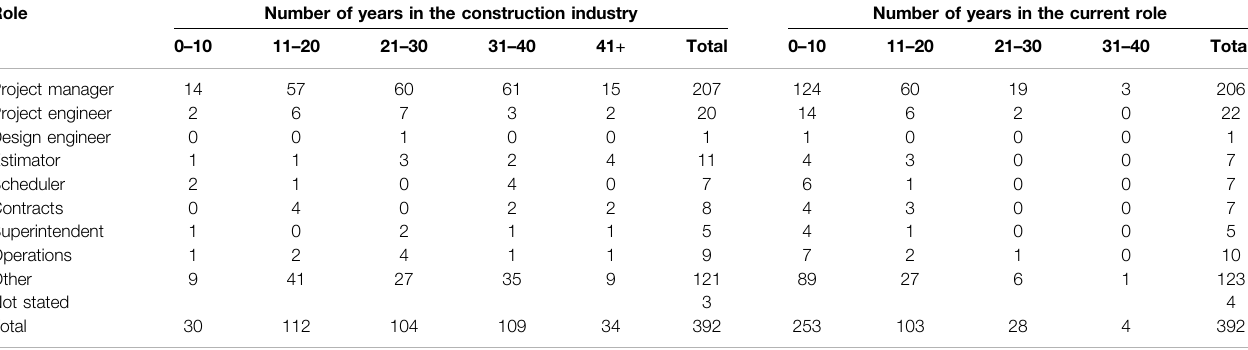
TABLE 3 | Respondents ’ role and work experience.